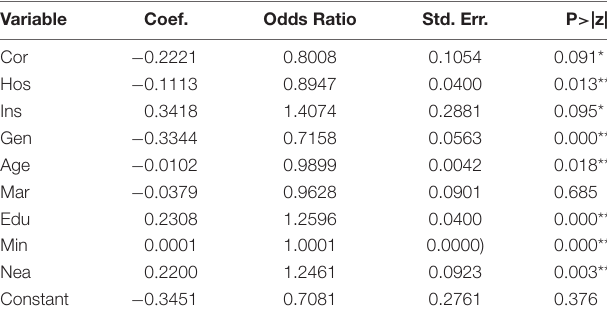
TABLE 3 | Baseline regression results.